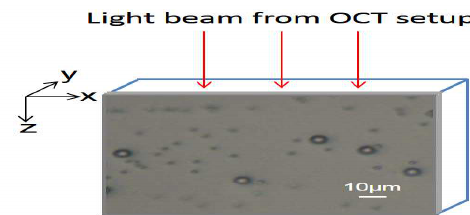
Figure 5. Cross-sectional view of the phantom sample imaged by Olympus upright microscope with 100 × magnification (the while bar denotes 10 µ